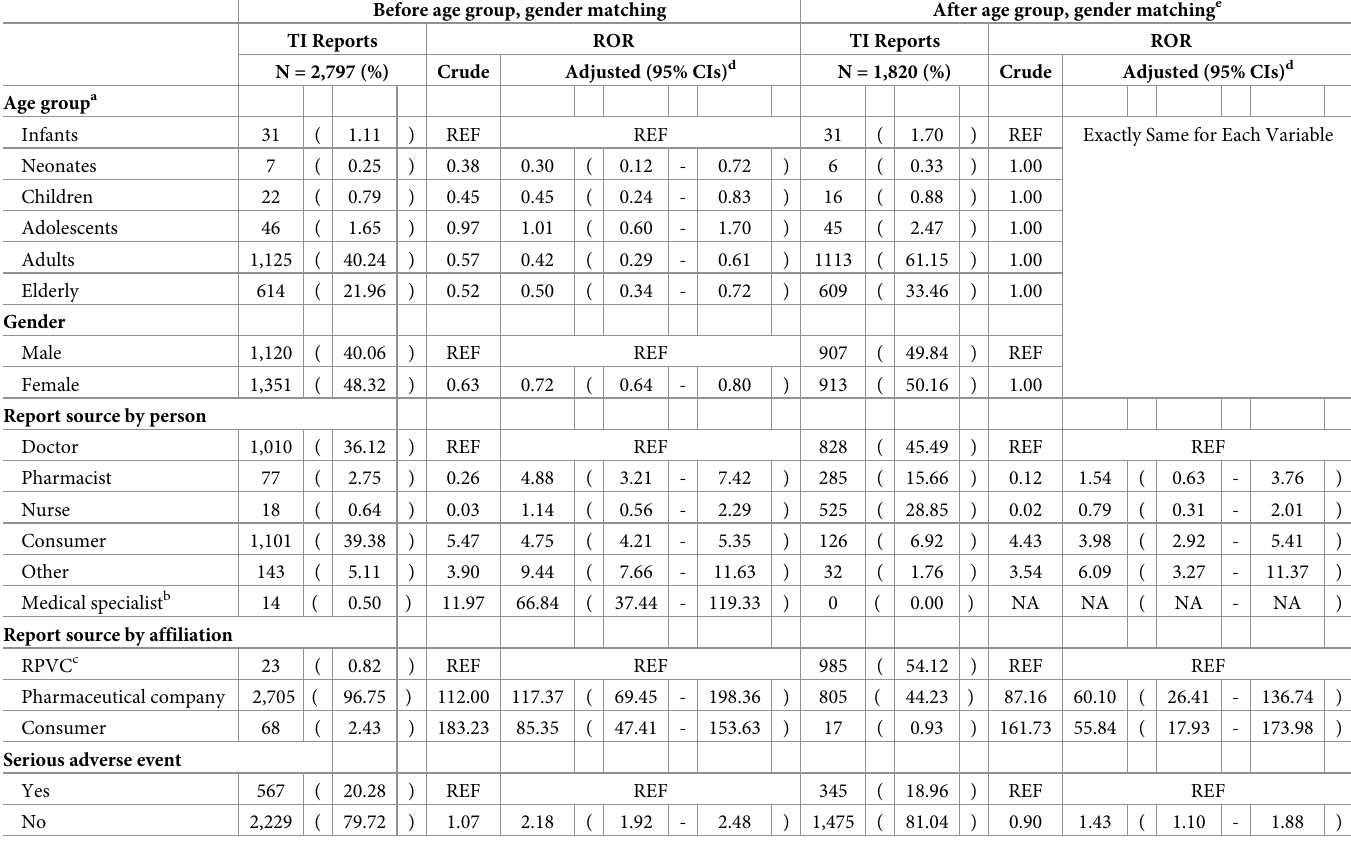
Table 2. Logistic regression model for the factors associated with therapeutic ineffectiveness occurrence rate according to the age group, gender, reporter, source of report, and serious adverse event from the KAERS database in